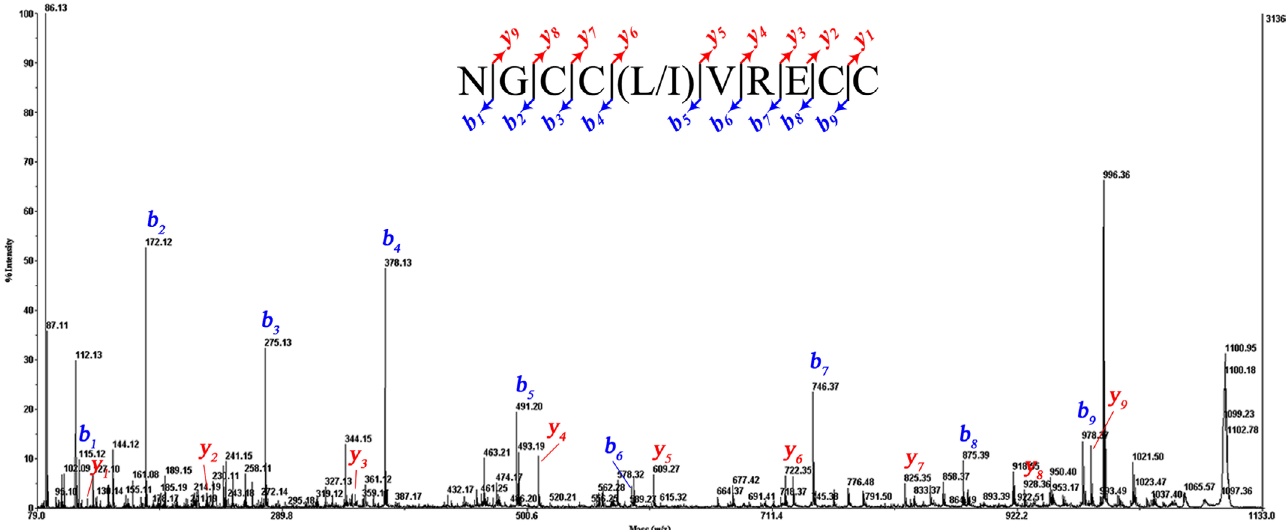
Figure 3. Primary structure determination of CID mass spectrum profile of reduced-Bn5a form, recorded with the MALDI-TOF/TOF 4800 mass spectrometer: The inset shows the sequence derived from these MS/MS spectra. Note m/z 86.13 corresponds to the immonium ion of Leu or